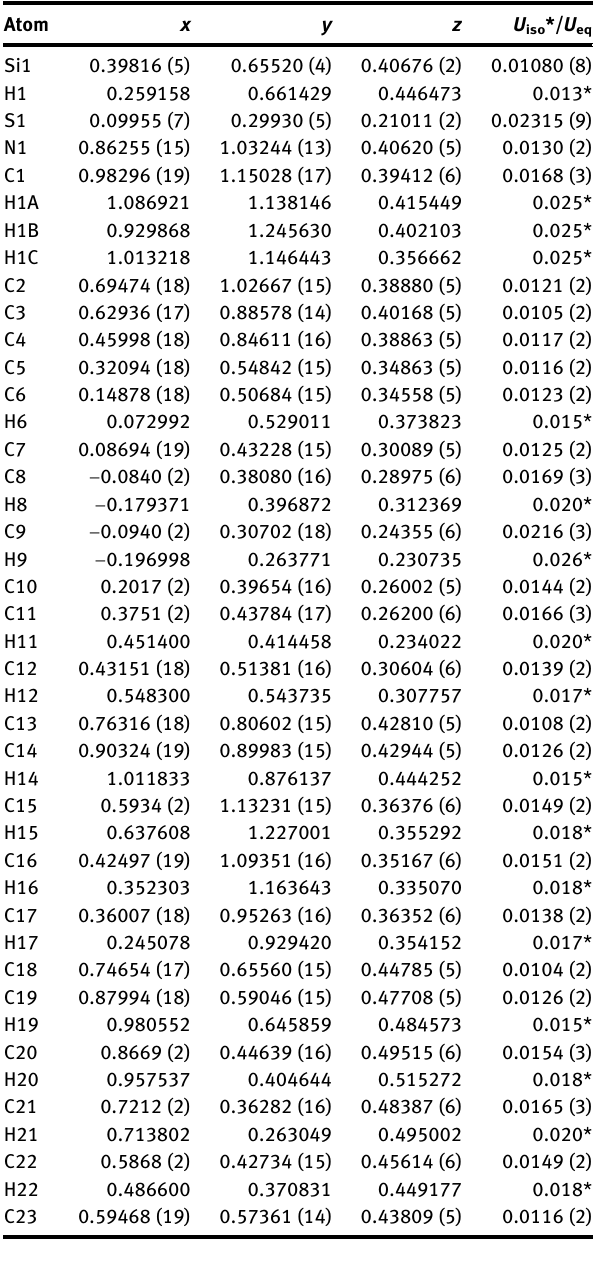
Table  : Fractional atomic coordinates and isotropic or equivalent isotropic displacement parameters (Å  ).